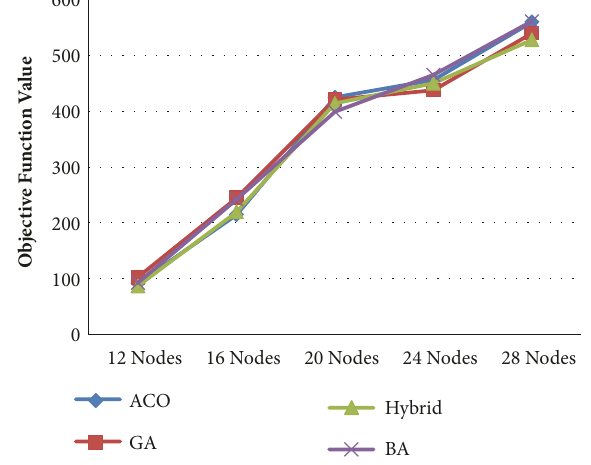
Figure 10: Average solution.